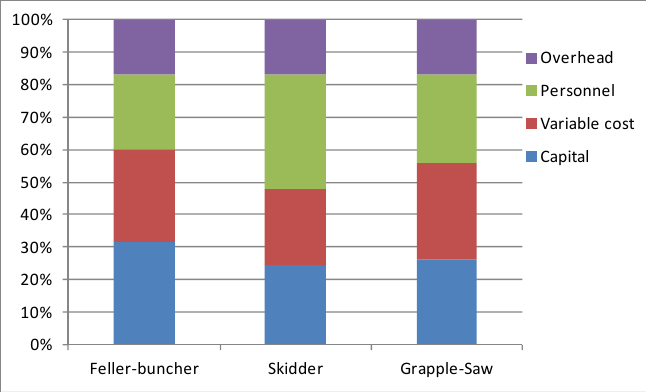
Figure 2. Cost breakdown for the main equipment on test.